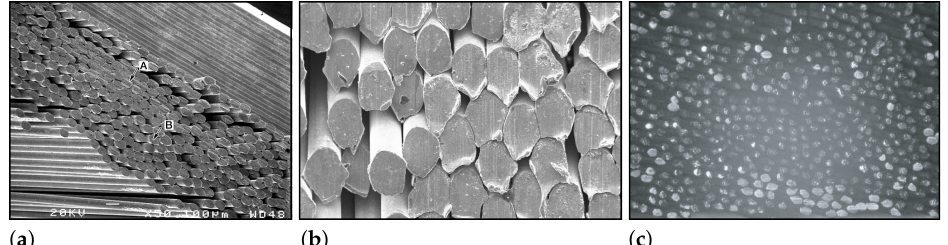
Figure 8. Zones with different contacts on the running surface; ( a ): Proctor et al. [42], ( b ): @ ITS, ( c ): Buscher